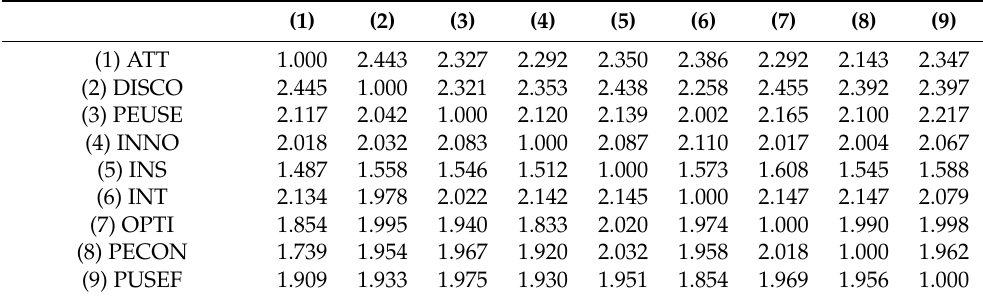
Table 1. Common Method Bias Test (Inner VIF).